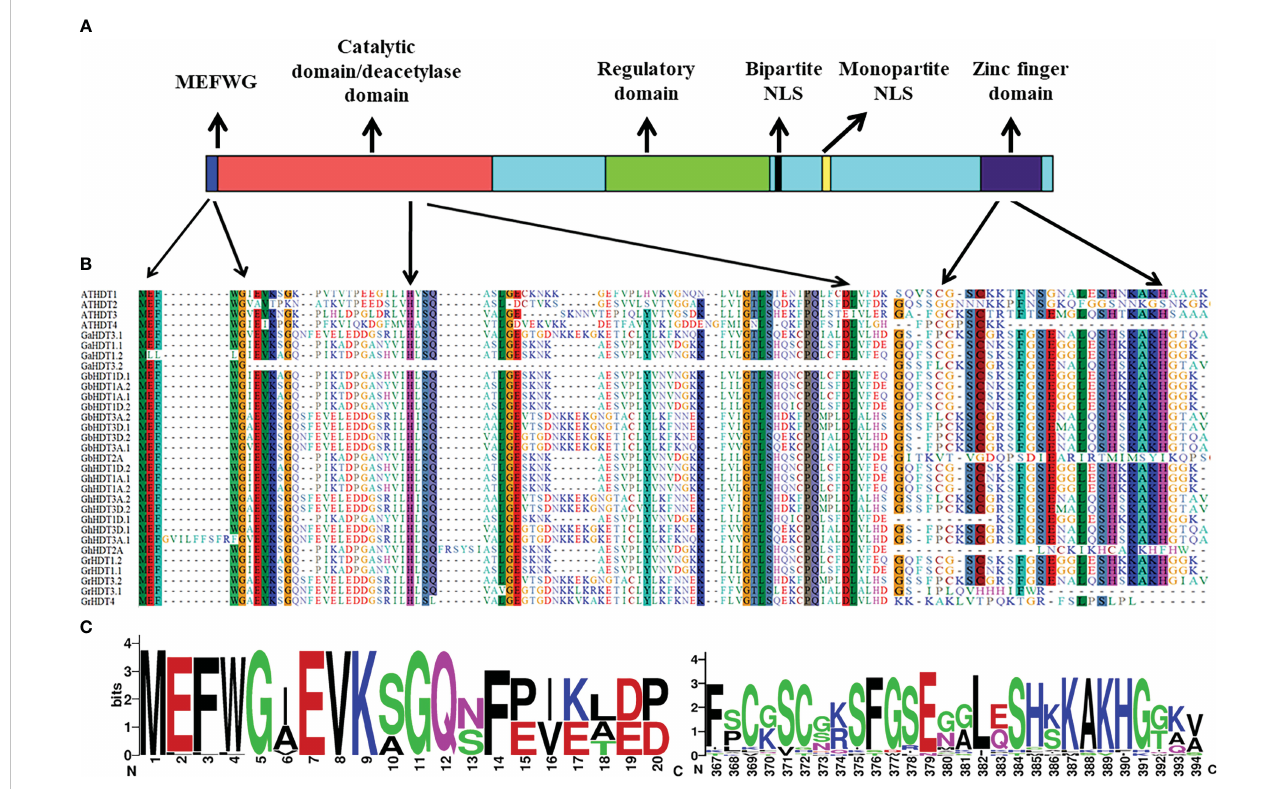
FIGURE 3 Conservation of HD2 domains in all cotton HD2 proteins. (A) Functionally con fi rmed motifs of Arabidopsis HD2s. (B) Alignment and sequence logo of the conserved MEFWG pentapeptide sequence of 27 cotton HD2s with that of 4 AtHD2s. (C) Alignment and sequence logo of the conserved zinc fi nger domain of 27 cotton HD2s with that of 4 AtHD2s.